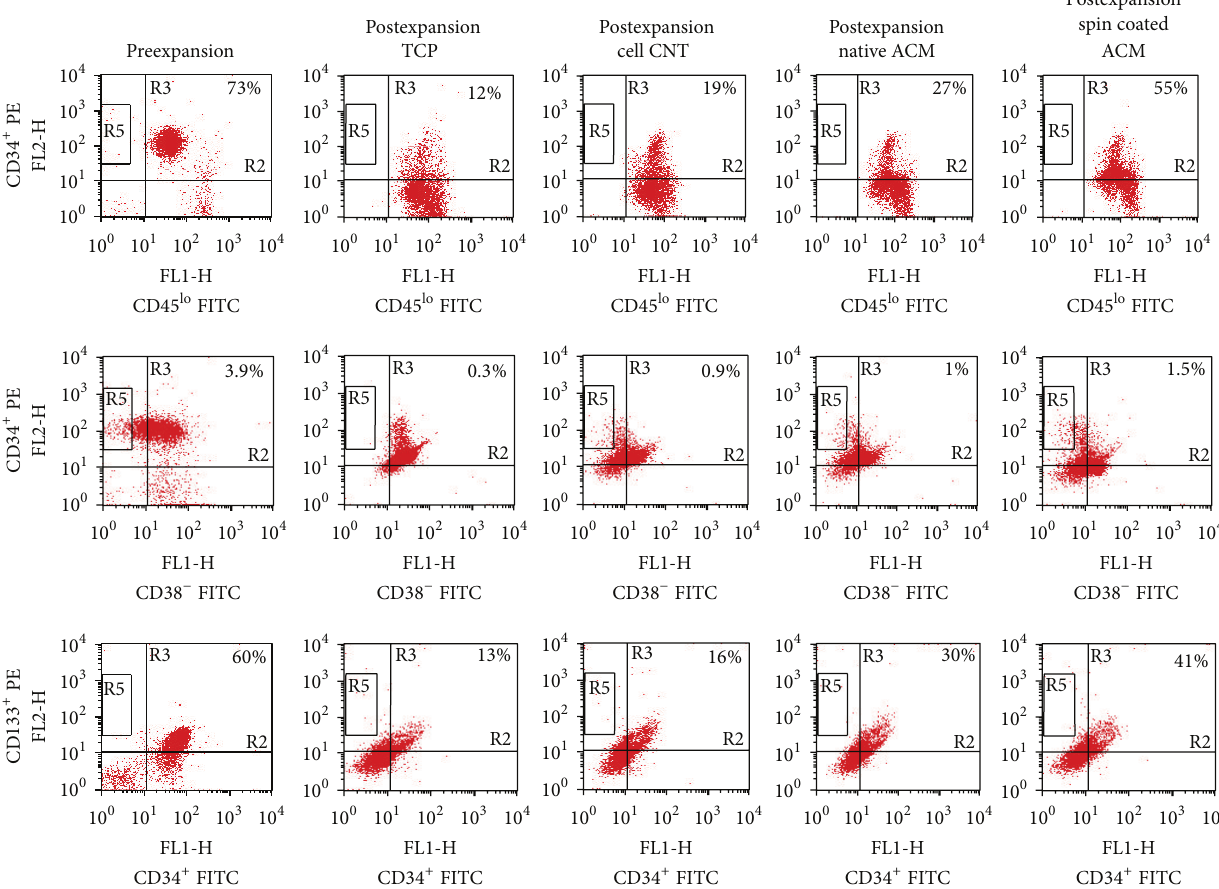
Figure 9: Representative dot plot image of surface marker-based flow cytometry assay indicating the percentage of CD34 + CD 45 lo , CD34 + CD38 − , and CD34 + CD133 + cell subsets in preexpanded cells and cells expanded on TCP, on cellular control, on native ACM, and on spin coated ACM.